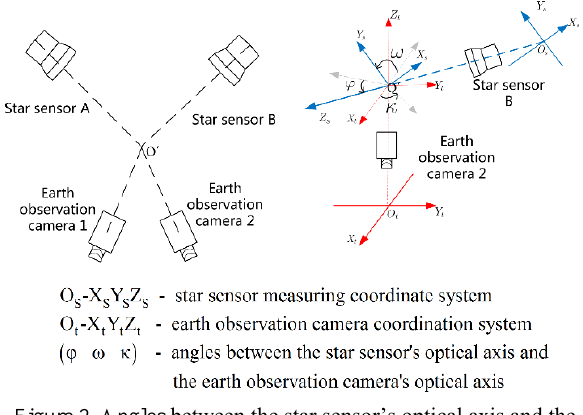
Figure 2. Angles between the star sensor’s optical axis and the earth observation camera’s optical